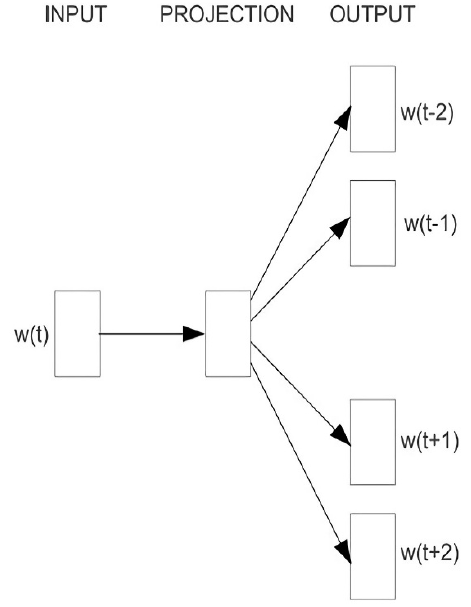
Figure 3. Surrounding words predicted by Skip ‐ Gram.